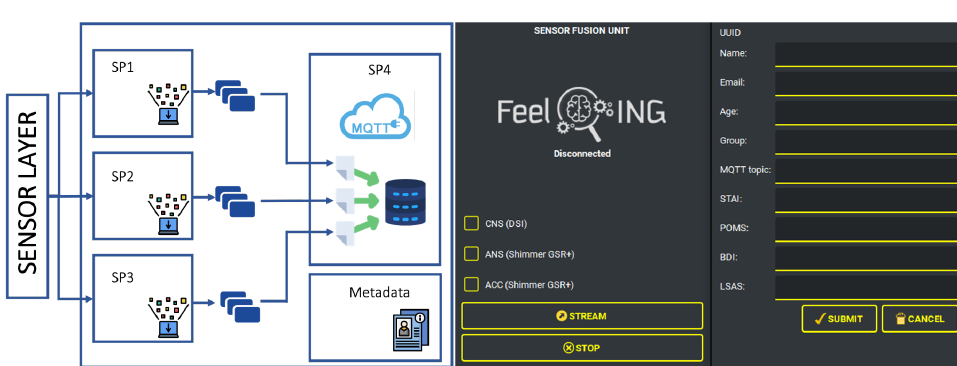
Figure 2. The sensor fusion unit (SFU). On the left: The sensor layer is composed of the wearable devices to be connected. SP1, SP2, and SP3 represent the dedicated acquiring subprocesses for the streaming devices. SP4 is the subprocess in charge of data gathering and streaming over the MQTT protocol. On the right: The PyQt6 user interface developed to handle the data acquisition from the Shimmer3 GSR+ unit and DSI-24 system alongside metadata and subjects’ personal